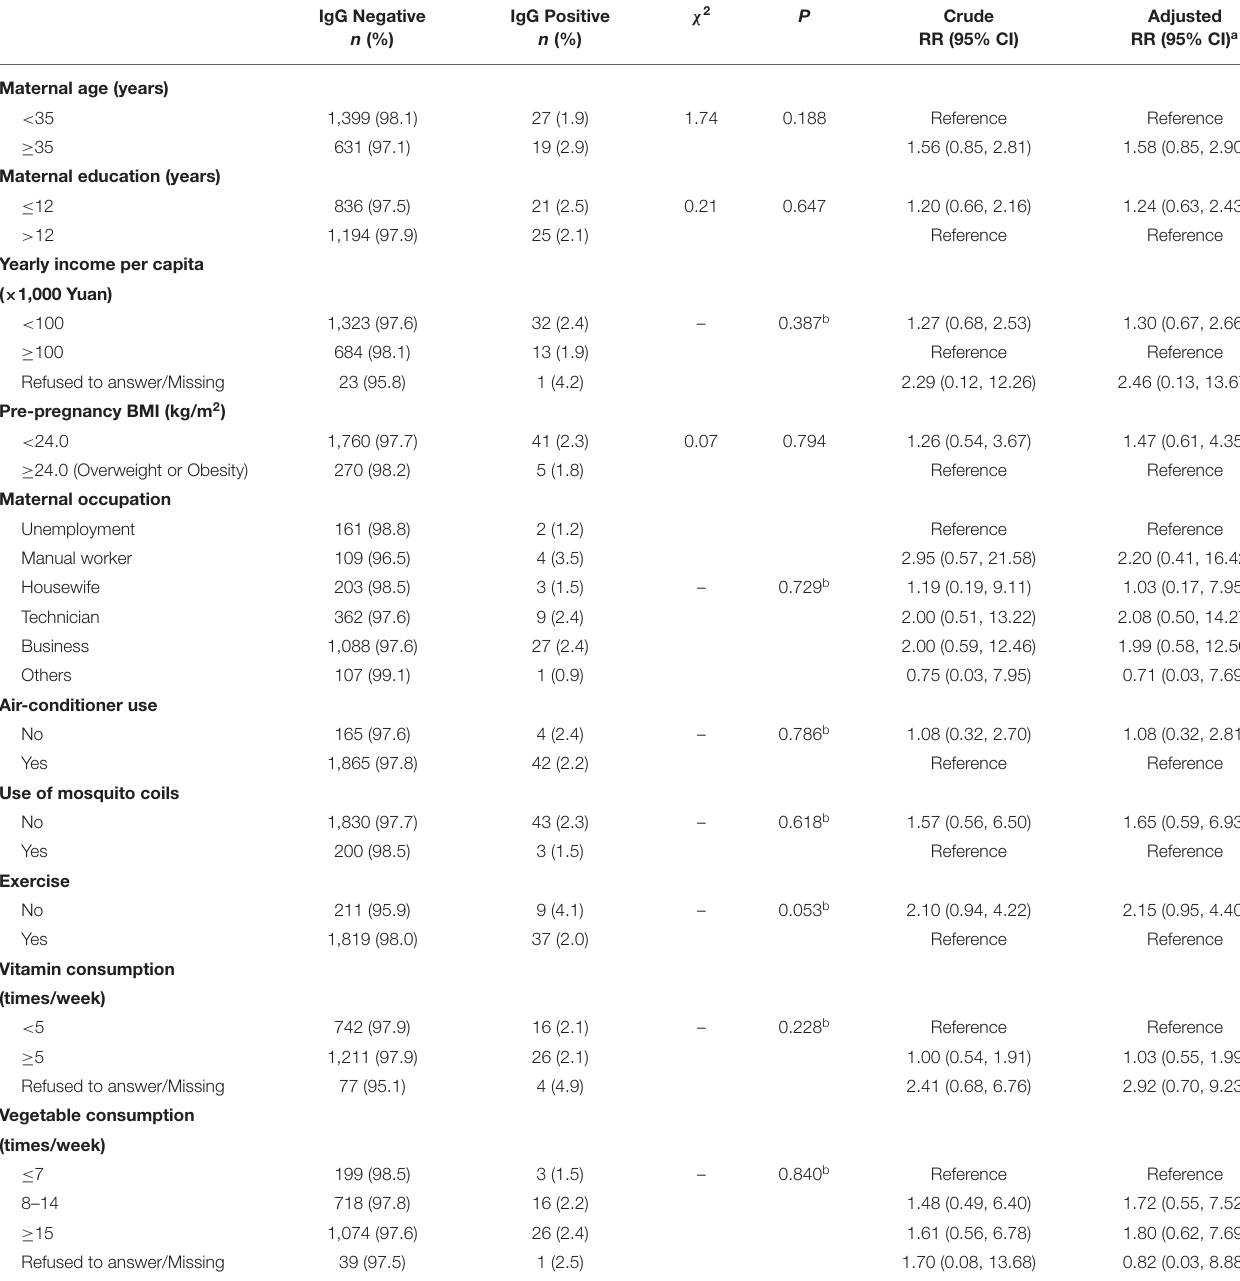
TABLE 2 | Variables related to positive IgG antibody of dengue fever ( n =